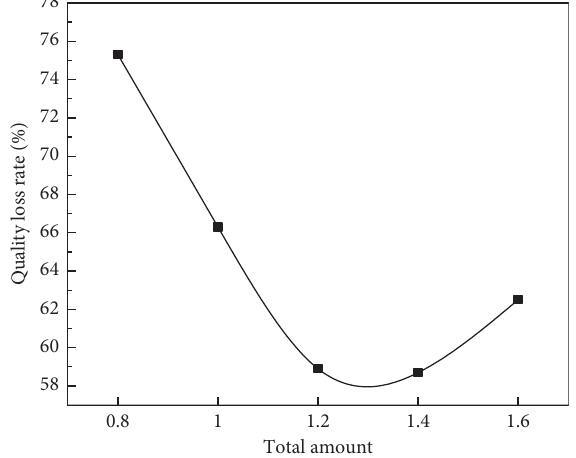
Figure 18: Mass loss rate of